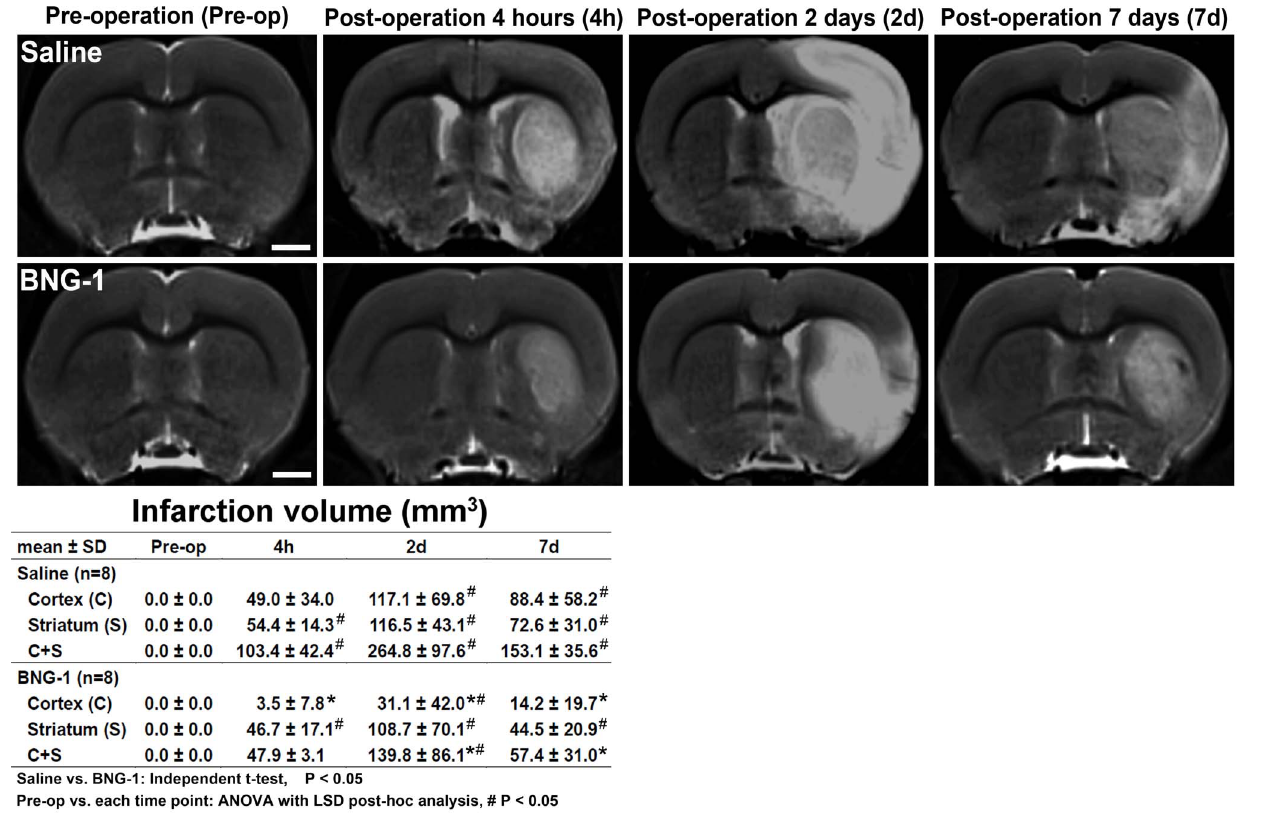
Fig. 1. Comparison of the temporal changes in the infarction volumes after focal cerebral ischemia between the saline and BNG-1 treatments. The T2-weighted image indicates that the infarction volume (white region) on the lesion cortex is smaller in the BNG-1 group than the saline group from as early as 4 h to 7 d. No striatum difference was observed. The bar in the pre-operation panels indicates 2.5